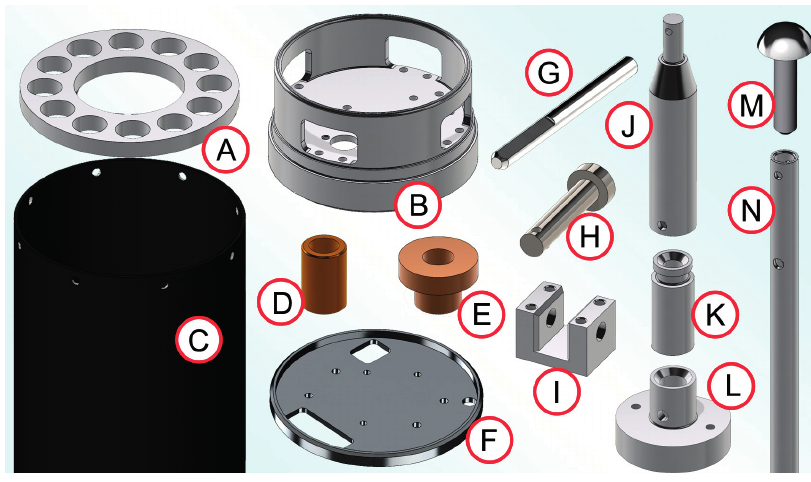
Figure 4. Student parts for Smokey machined in the rocketry